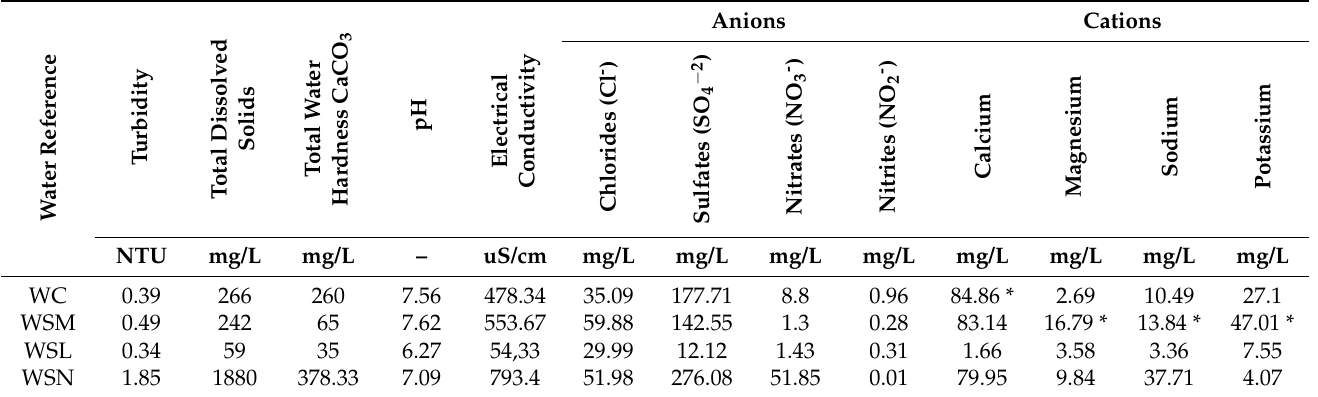
Table 4. Physicochemical properties of the types of